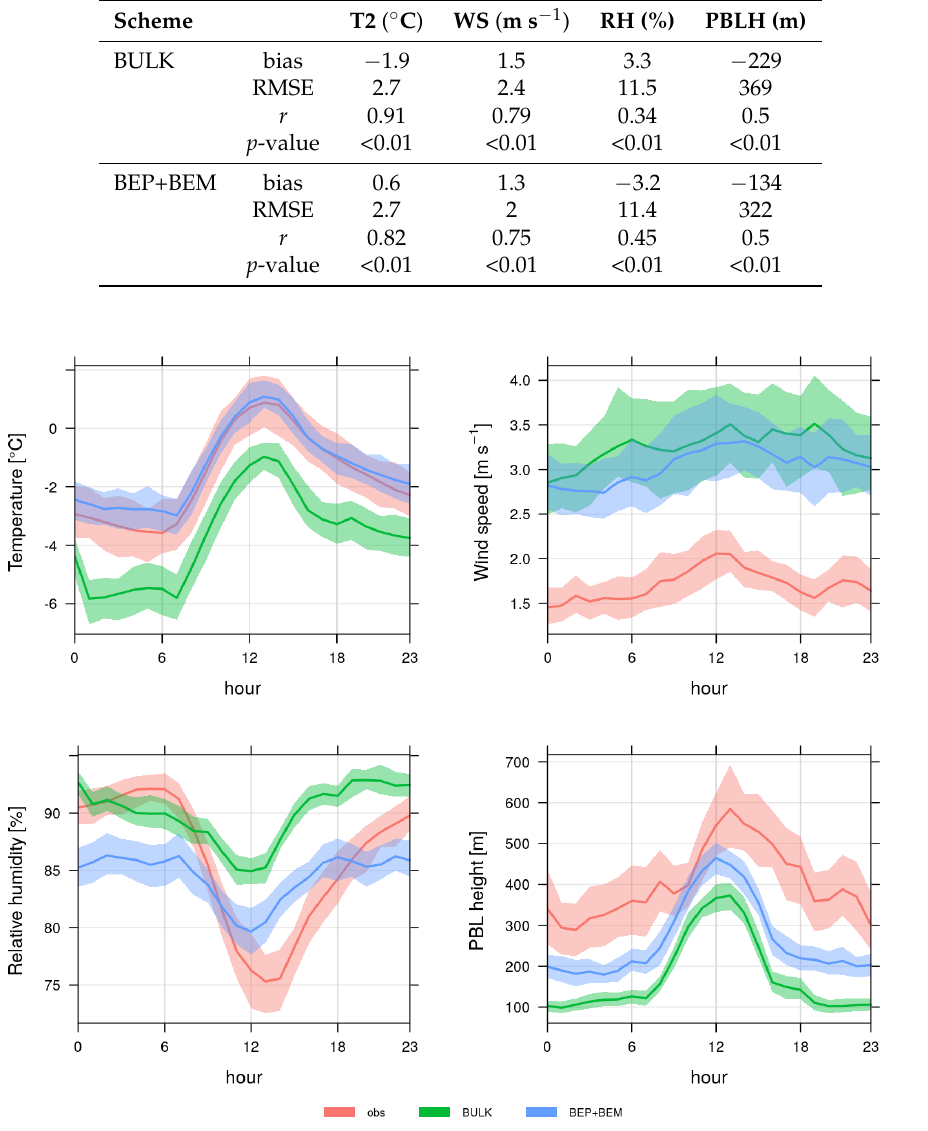
Table 2. Statistical results (bias, RMSE, r , correlation p -value) of observations and simulations with corresponding units for bias and RMSE: meteorology; hourly averages. T2, Temperature at 2 m; WS, Wind Speed.